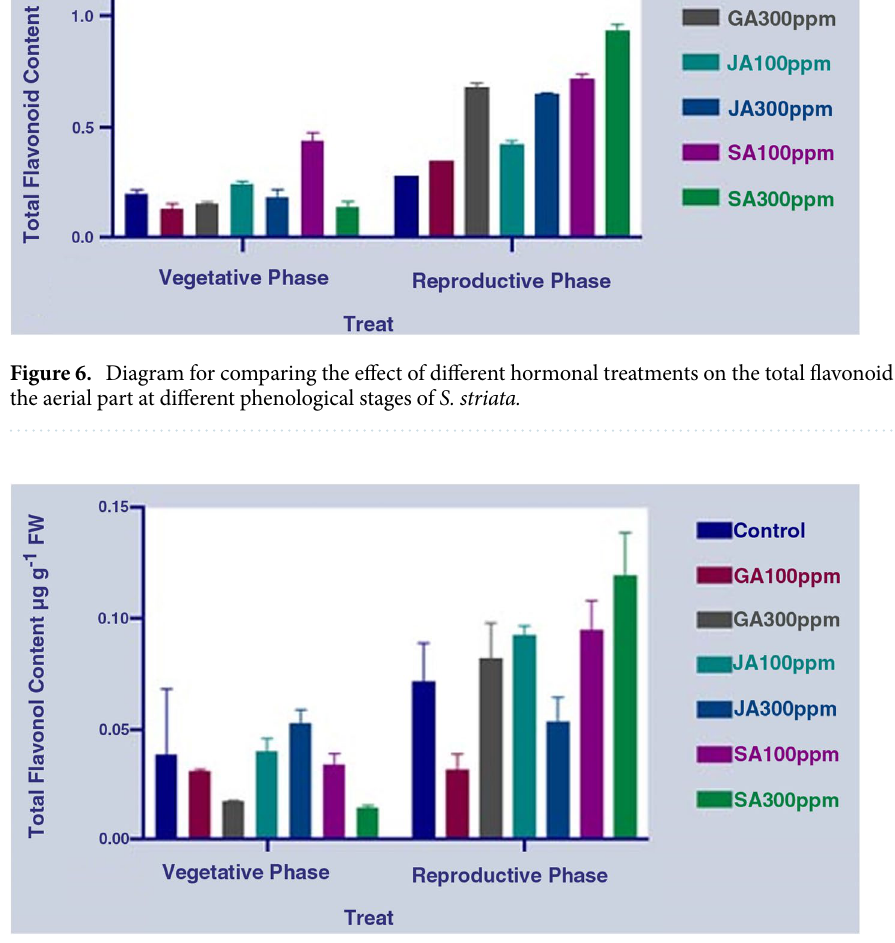
Figure 7. Diagram for comparing the effect of different hormonal treatments on the total flavonol content in the aerial part at different phenological stages of S. striata